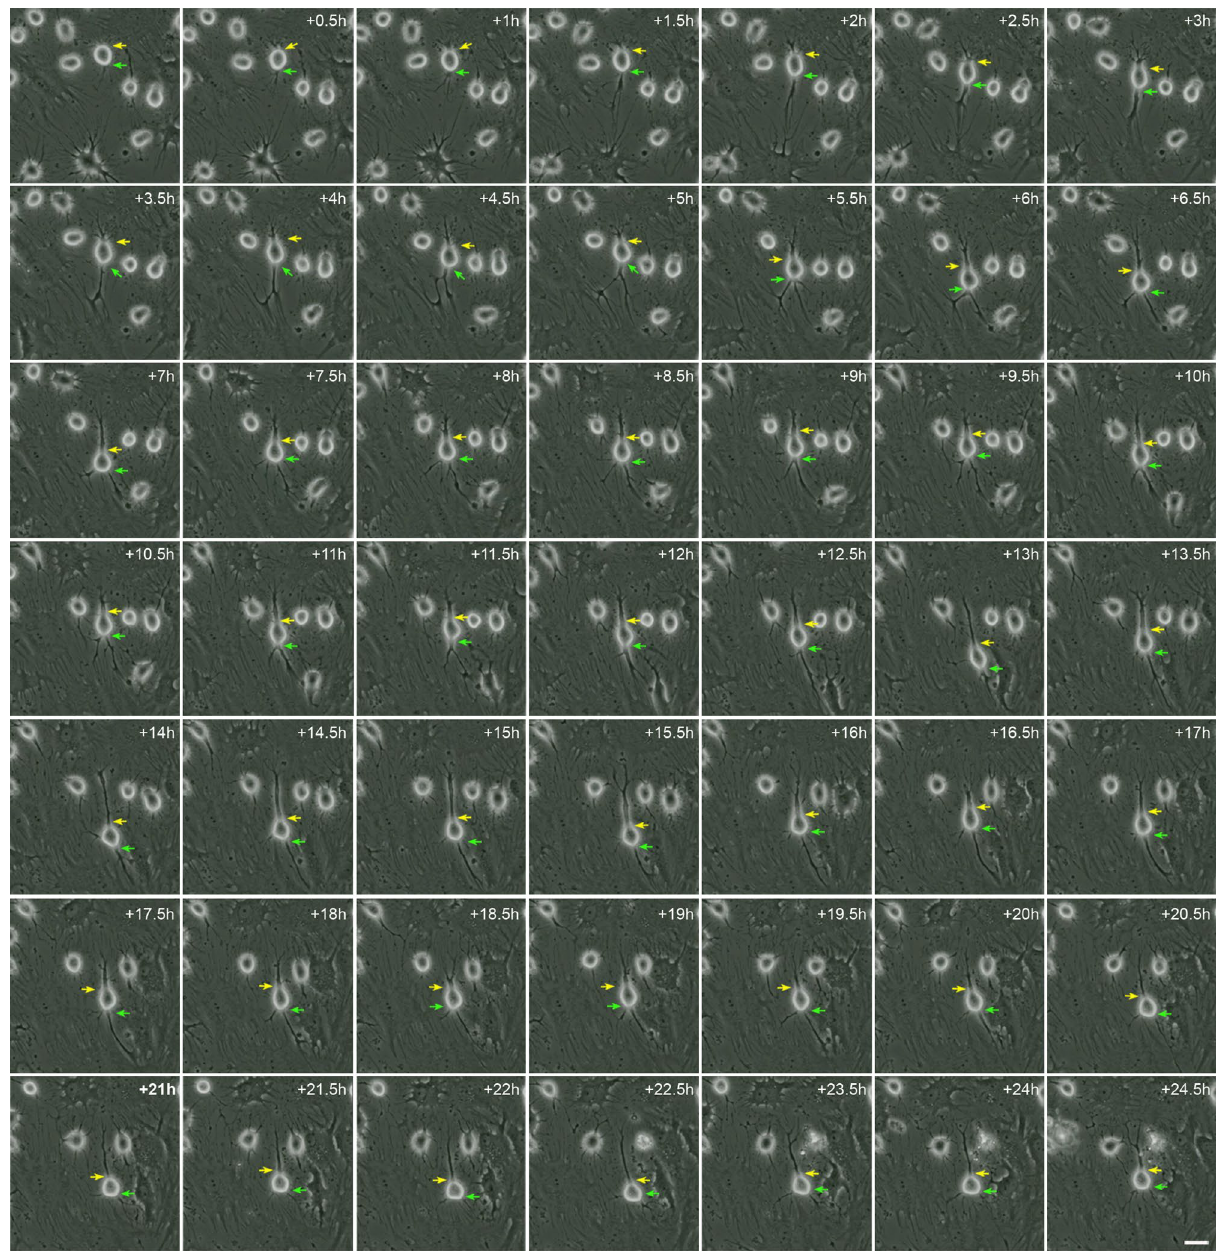
Figure 2. Neuronal-like polarisation of hBM-MSC-derived intermediate cells. Time-lapse imaging revealed the growth of new neurites from the body of round cells (intermediate cells) that which gradually adopted a complex morphology, acquiring dendrite-like (green arrows) and axon-like domains (yellow arrows). There was no observation of major transient cellular protrusion as hBM-MSC-derived intermediate cells gradually acquired a neural-like morphology. Scale bar: 25